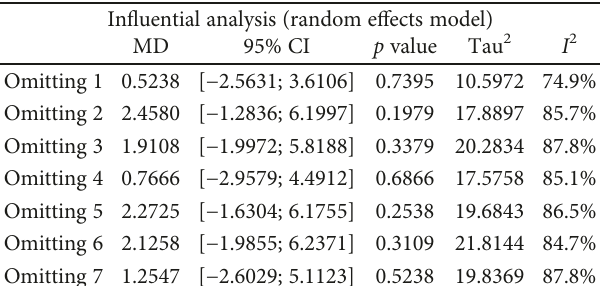
Table 4. Egger ’ s regression asymmetry test showed no evi-